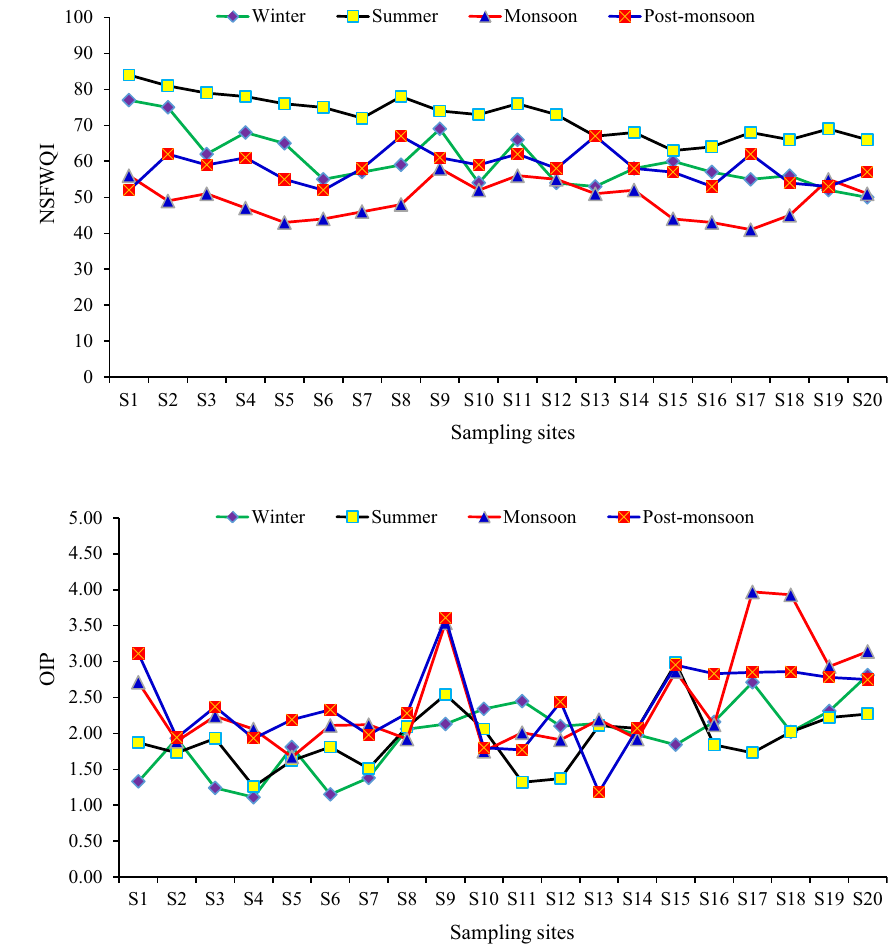
Fig. 4 Seasonal variation in NSFWQI values for each moni- toring stations